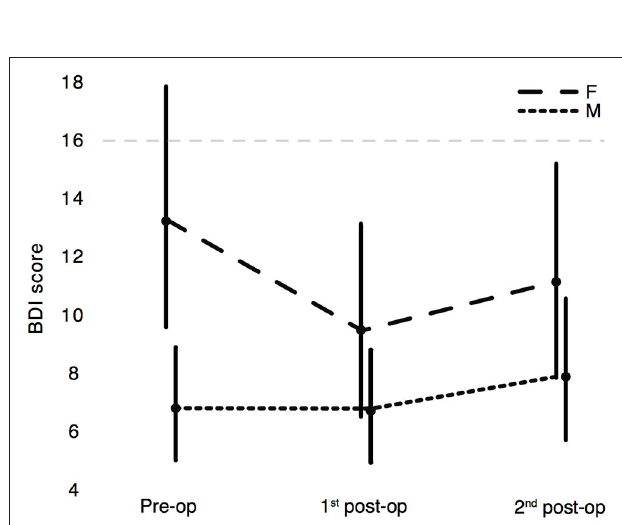
FIGURE 2 | Estimated marginal means of BDI-I scores with 95% CI. Assessment of depressive symptoms in PD patients at the three experimental stages: pre-operation, 1st post-operation, 2nd post-operation separated by sex: F = female, M = male. The dashed horizontal line at value 16 represents the cut-off for PD